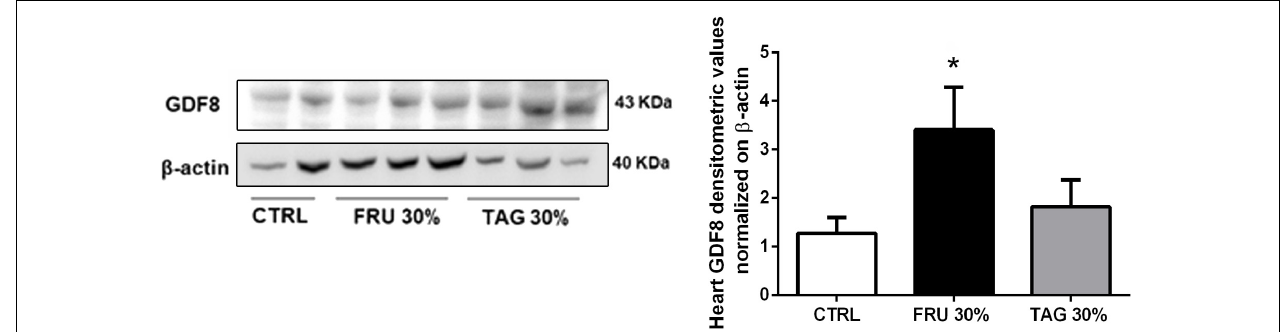
FIGURE 9 | Effects of sugar feeding on expression of Growth/Differentiation Factor 8 (GDF8). Representative immunoblots and relative densitometric analysis of the expression of GDF8 in heart samples of rats fed with CTRL, FRU 30% or TAG 30%. Densitometric data are reported as relative optical density (OD), corrected for the corresponding β -actin contents. Data are means ± SD for 8 (CTRL and TAG 30%) and 7 (FRU 30%)animals per group; * p < 0.05 vs. CTRL and # p < 0.05 vs. TAG